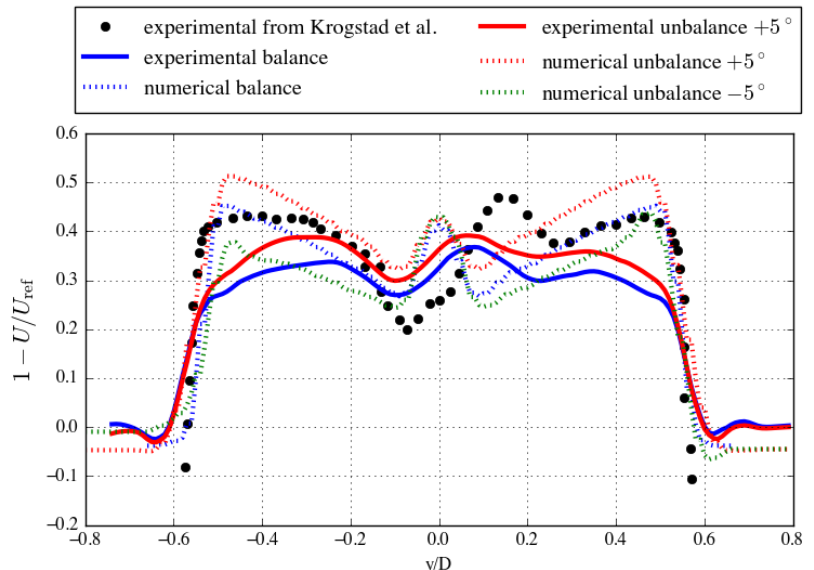
Figure 11. Numerical (dotted line) and experimental (solid line) profiles of the normalised velocity deficit at hub height for the balanced (blue lines) and unbalanced (red lines) cases at x / D = 1. The black circles are measurements from Krogstad and Eriksen [10]. (Green dotted lines) numerical simulations with negative pitch imbalance.